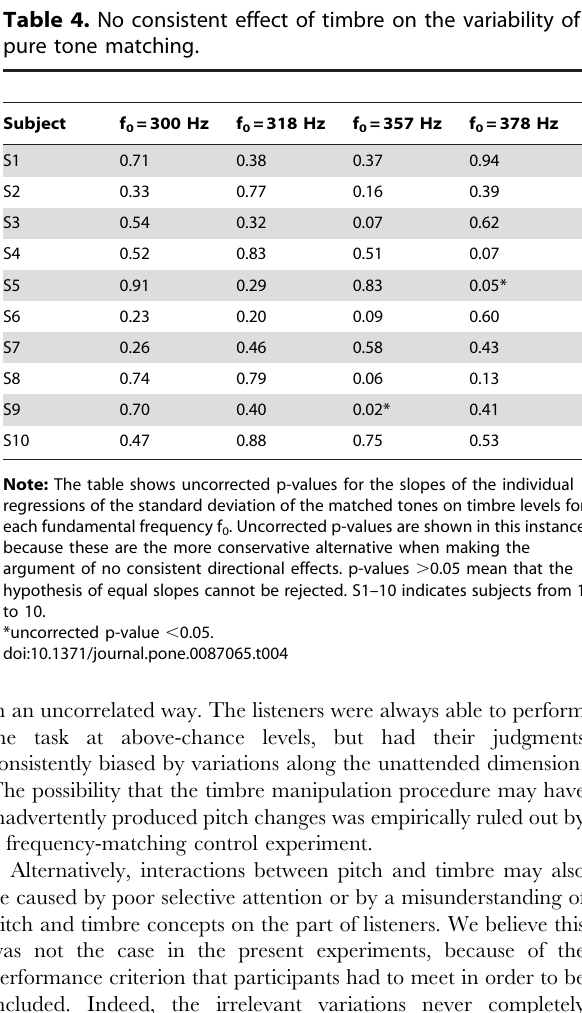
Table 4. No consistent effect of timbre on the variability of pure tone matching.